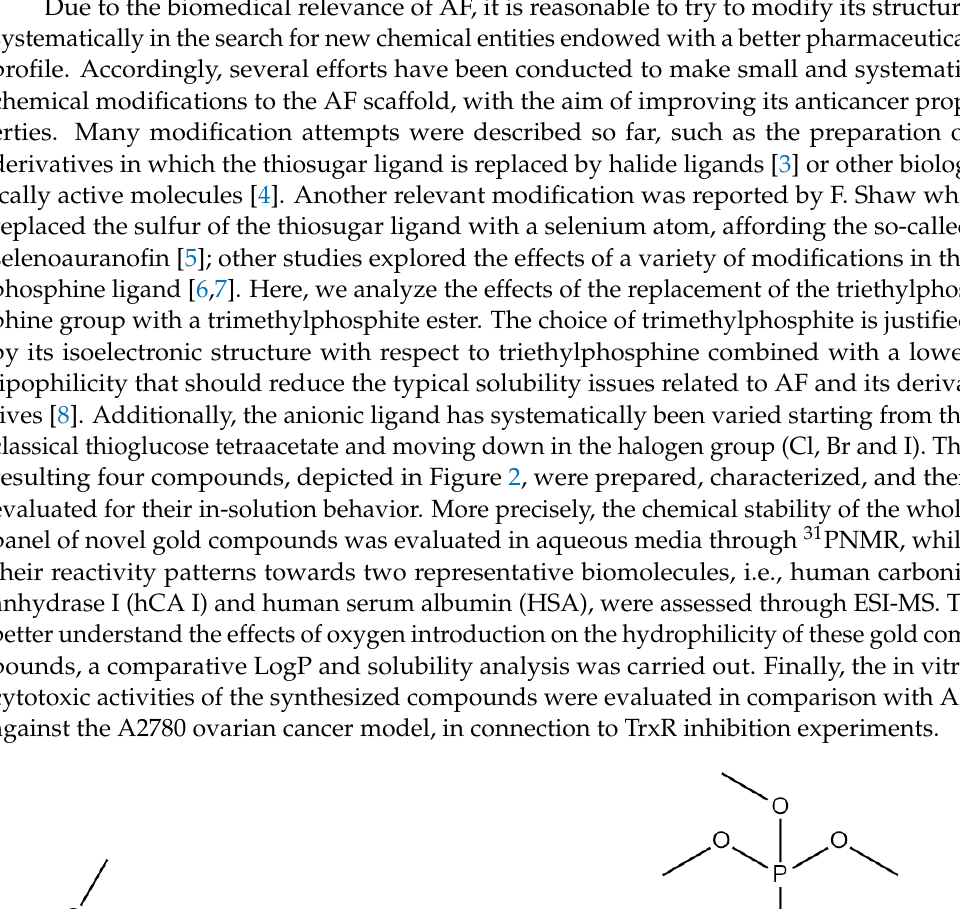
Figure 1. Auranofin structure.